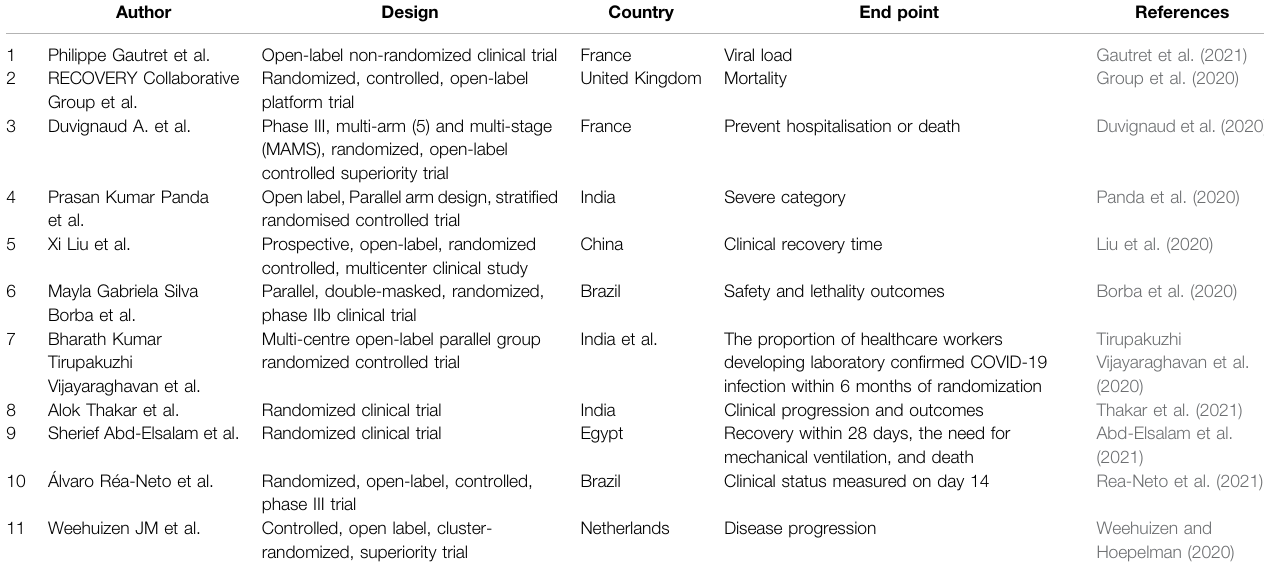
TABLE 1 | Main clinical trials of Chloroquine for